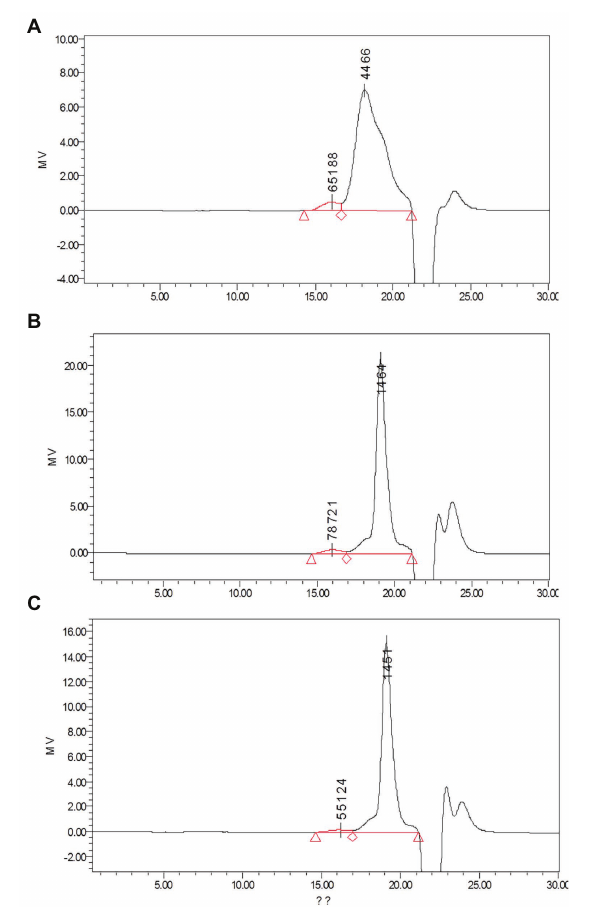
FIGURE 5 | Molecular weight of the three polysaccharides. (A) APP40; (B) APP60; and (C)